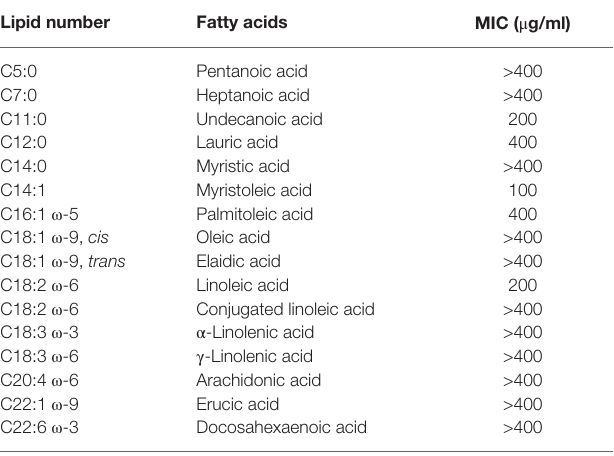
TABLE 1 | MICs of fatty acids for Staphylococcus aureus ATCC